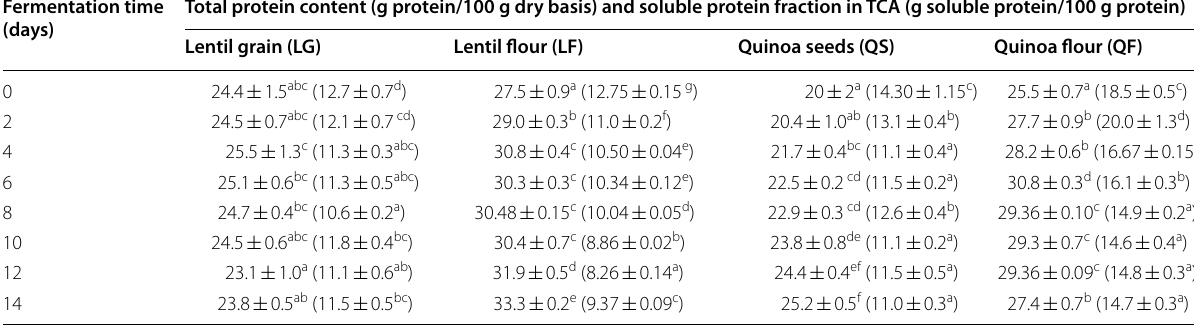
The results represent the mean of three repetitions with their standard deviation. abcdef lowercase letters indicate significant differences between the different fermentation times at the 95% ( p < 0.05) significance level * Values in parentheses correspond to soluble protein fraction in TCA